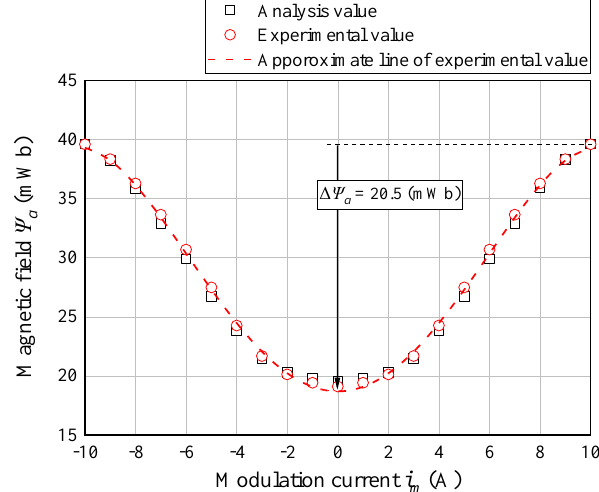
Figure 15. Experimental result of Ψ a and its approximate line.